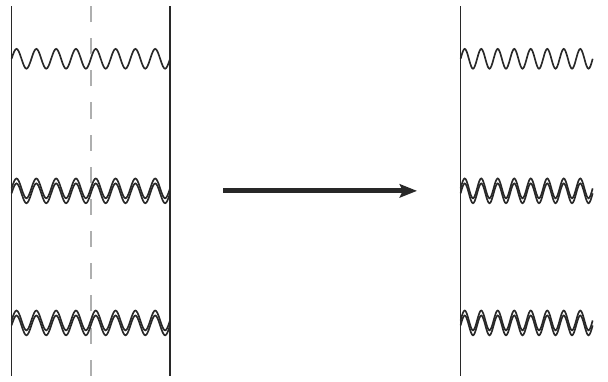
Fig. 1 Unitarity method for the scattering of two massive particles interact with gravitons and photons, at loop level. The straight lines represent the charged massive objects, the wavy lines stand for photons, and the double-wavy lines stand for